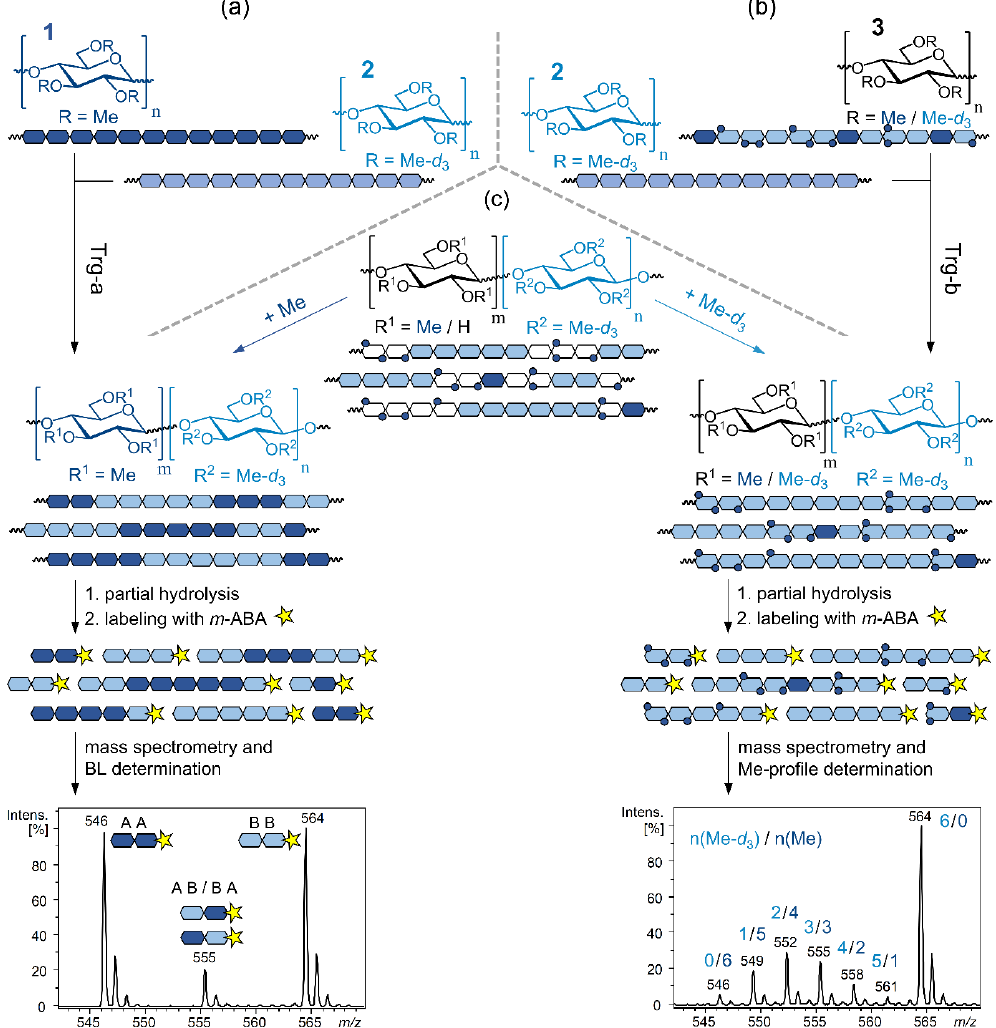
Figure 5. Schematic demonstration of the preparation of blocky glucan ether structures ( a , b ) by transglycosylation (Trg), the analytical procedure ( c ) for structural characterization of the products by ESI-LC-MS, and typical mass spectra for DP2 of the glucan-derived COS. Reproduced from Figure 1 of Ref. [68]: Hashemi, P.; Mischnick, P. Anal. Bioanal. Chem. 2020 , 412 , 1597–1610.